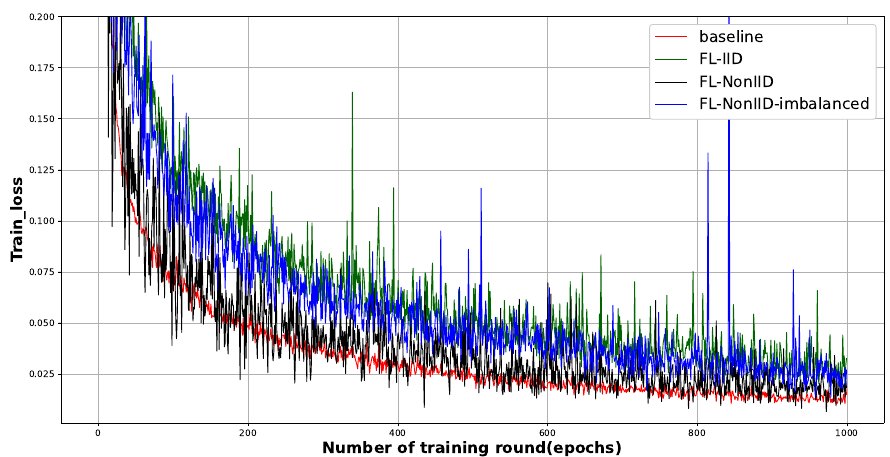
Figure 4. The figure shows the training loss of four schemes, i.e., the centralized CNN-based deep learning model (baseline) and the CNN-based deep learning model with FL on three data distributions—IID, non-IID, and non-IID imbalanced. Training rounds ran up to 1000